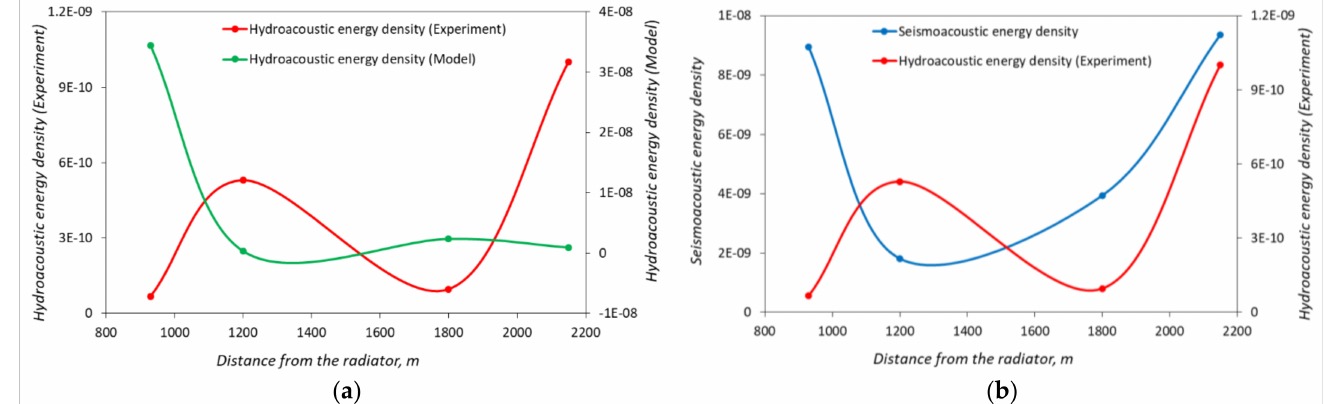
Figure 4. ( a ) Comparison of the energy densities of oscillations recorded by the laser strainmeter and the energy densities of the experimentally measured hydroacoustic signals; ( b ) comparison of energy density values of elastic oscillations: energy density of the experimentally measured hydroacoustic signals and energy densities calculated according to the model.